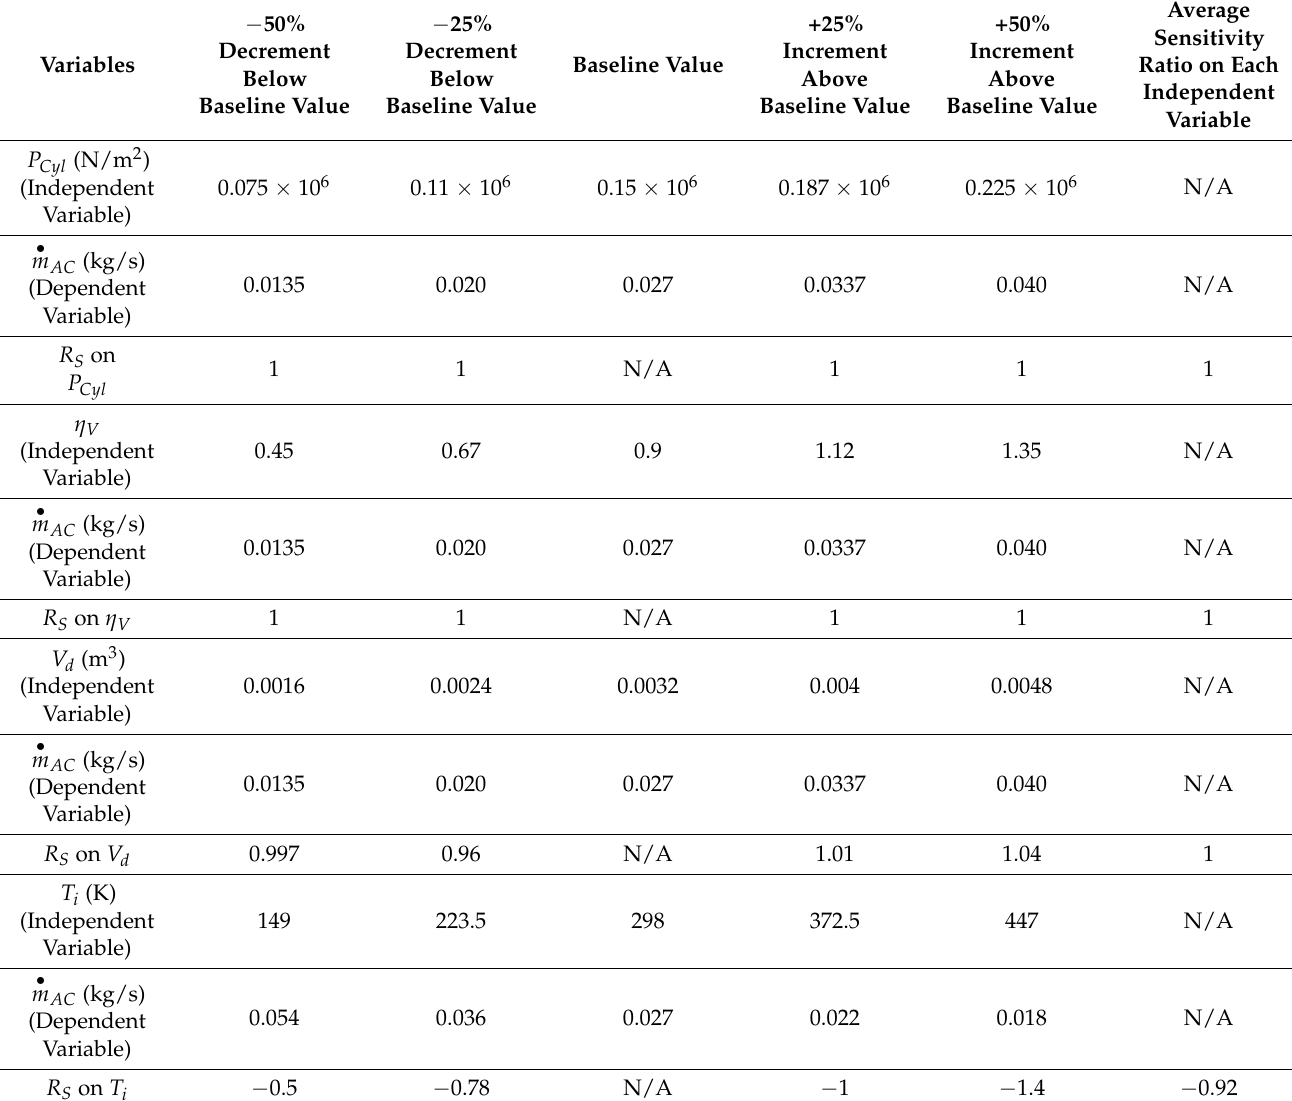
• m AC at the crank angle of opening the intake valve θ IVO